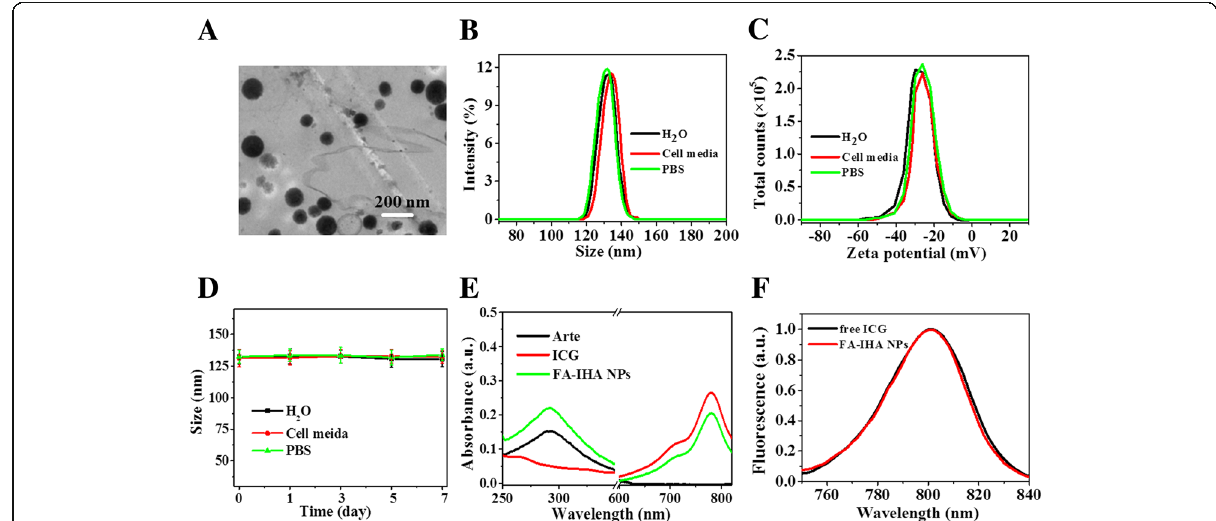
Fig. 2 a TEM image of FA-IHA NPs. b , c Size and zeta potential distribution of FA-IHA NPs in water, cell medium, and PBS. d FA-IHA NPs size change in water, cell medium, and PBS. e Absorbance spectra of free ICG, Arte, and FA-IHA NPs. f Fluorescence spectra of free ICG and FA-IHA